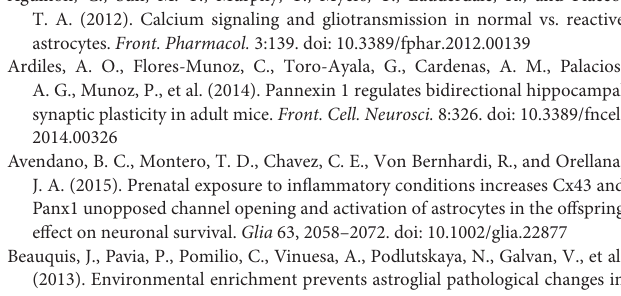
mean ± S.E.M., n = 3. FIGURE S2 | Prenatal LPS exposure does not affect total level and distribution of Cx43 in astrocytes. (A,B) Representative confocal images depicting GFAP (green) and Cx43 (red) staining by astrocytes in acute slices from control offspring (A) or prenatally LPS-exposed offspring of 4-month old (B) . (C–F) Insets of astrocytes and examples of draws for staining analysis were taken from the area depicted within the white squares in (A,B) . Calibration bars: white = 120 µ m; yellow = 20 µ m. (G) Quantification of membrane, intracellular and total staining of Cx43 by astrocytes in acute slices from control offspring (white bars) or prenatally LPS-exposed offspring of 4 months old (black bars). Data were obtained from at least three independent experiments with three or more repeats each one ( ≥ 20 cells analyzed for each